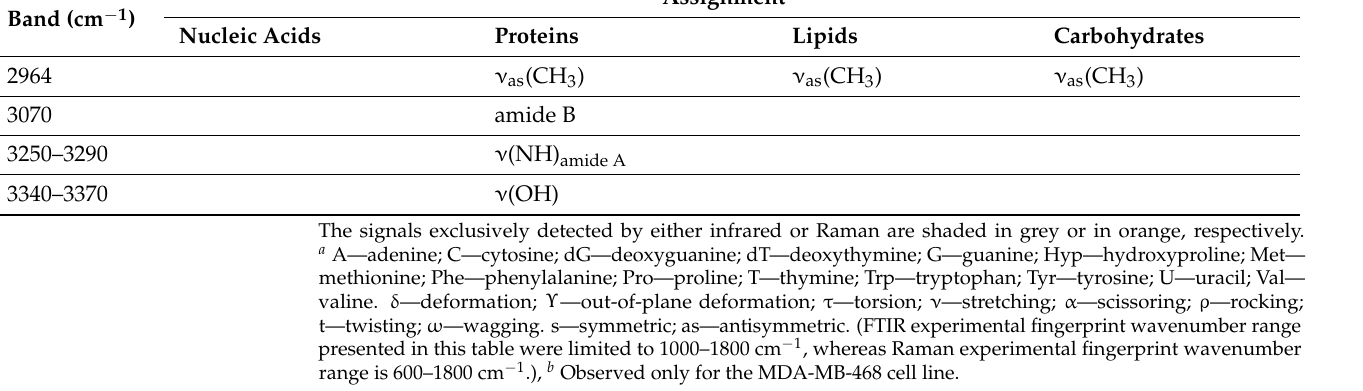
MDA-MB-468, HCC-1143 and